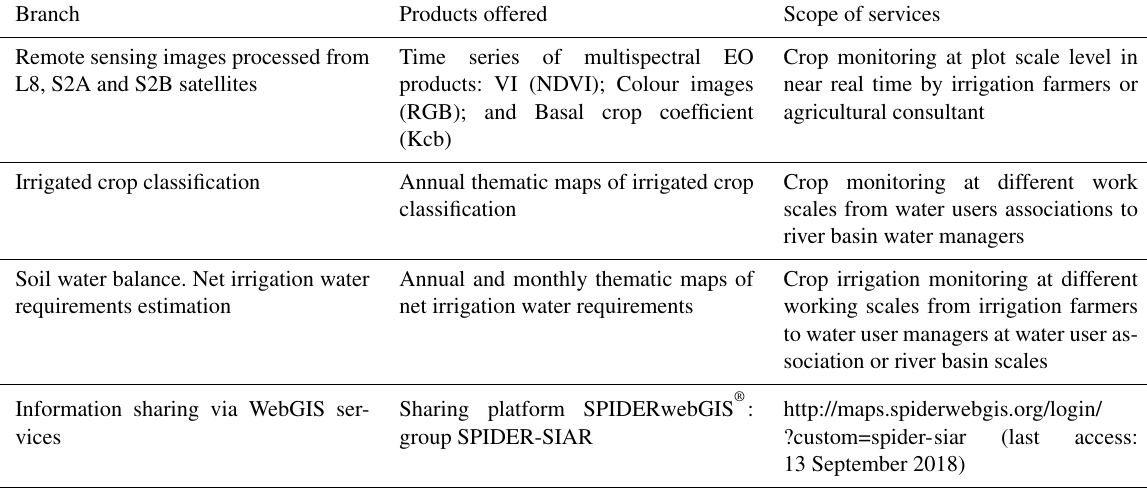
Table 1. SPIDER-SIAR products and scope of its services regarding different water user types. Branch Products offered Remote sensing images processed